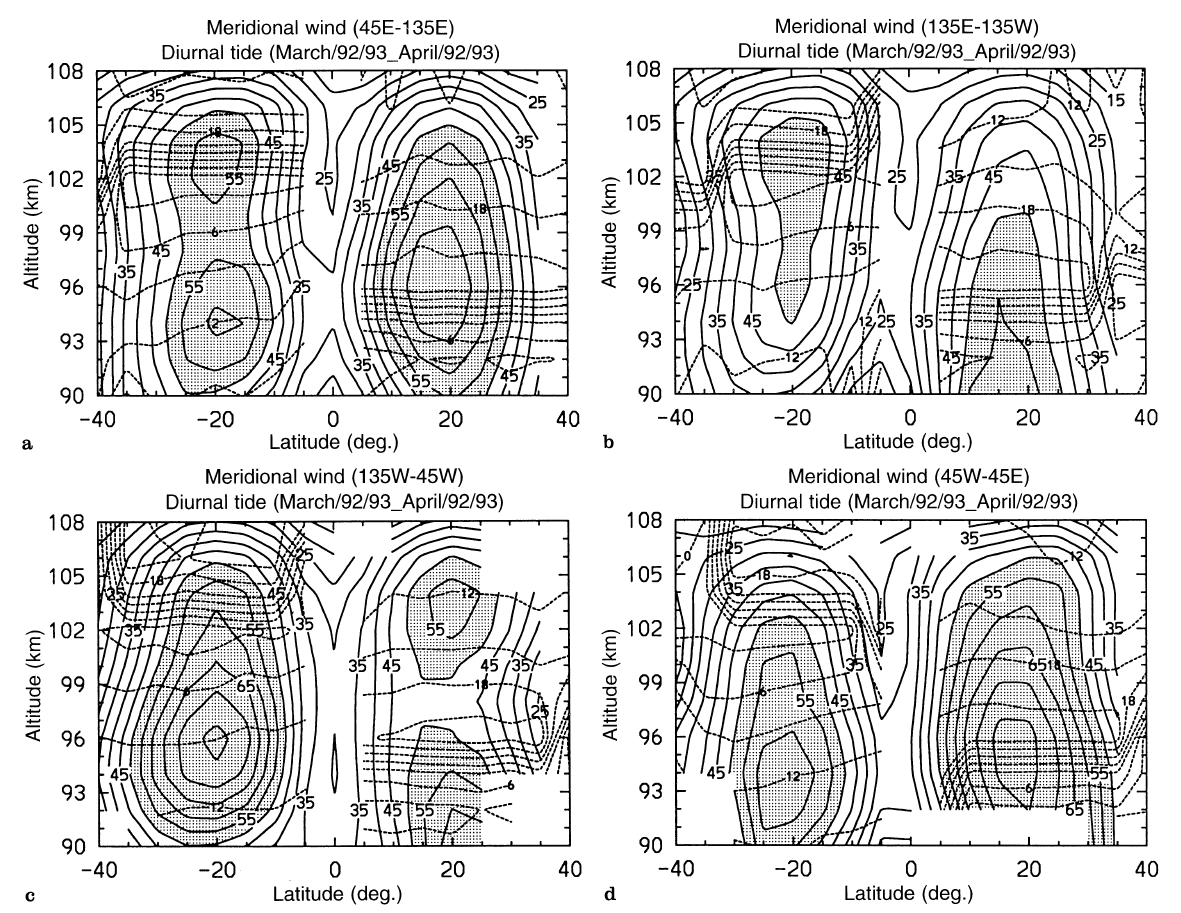
to 45 (cid:176) W, and d 45 (cid:176) W to 45 (cid:176) E longitude sectors. Amplitude contours >50 m/s are shaded. The phase (local time of maximum) is contoured using a